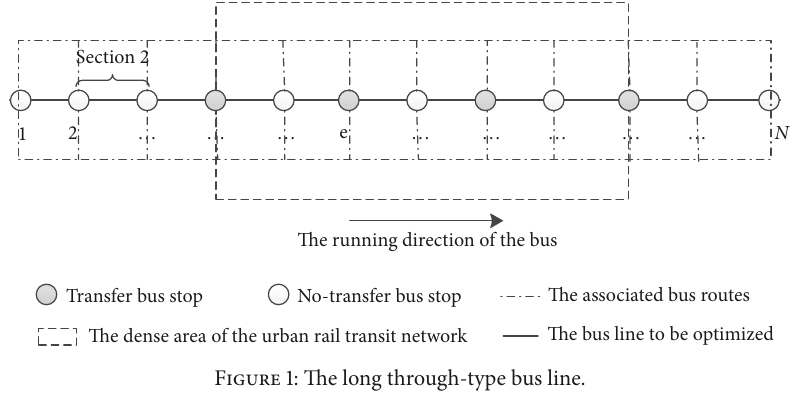
Figure 1: The long through-type bus line.